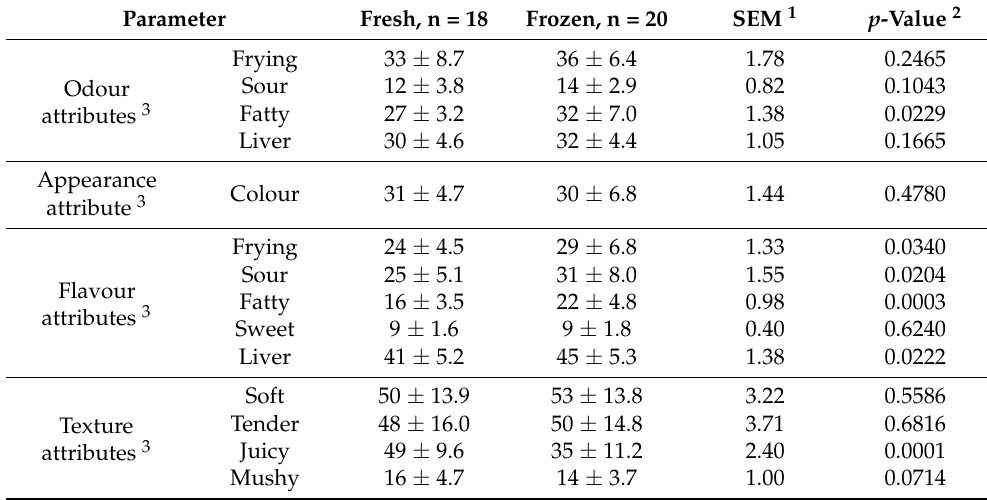
Table 2. Results of sensory analyses comparing muscle samples from fresh meat and meat after frozen storage for three